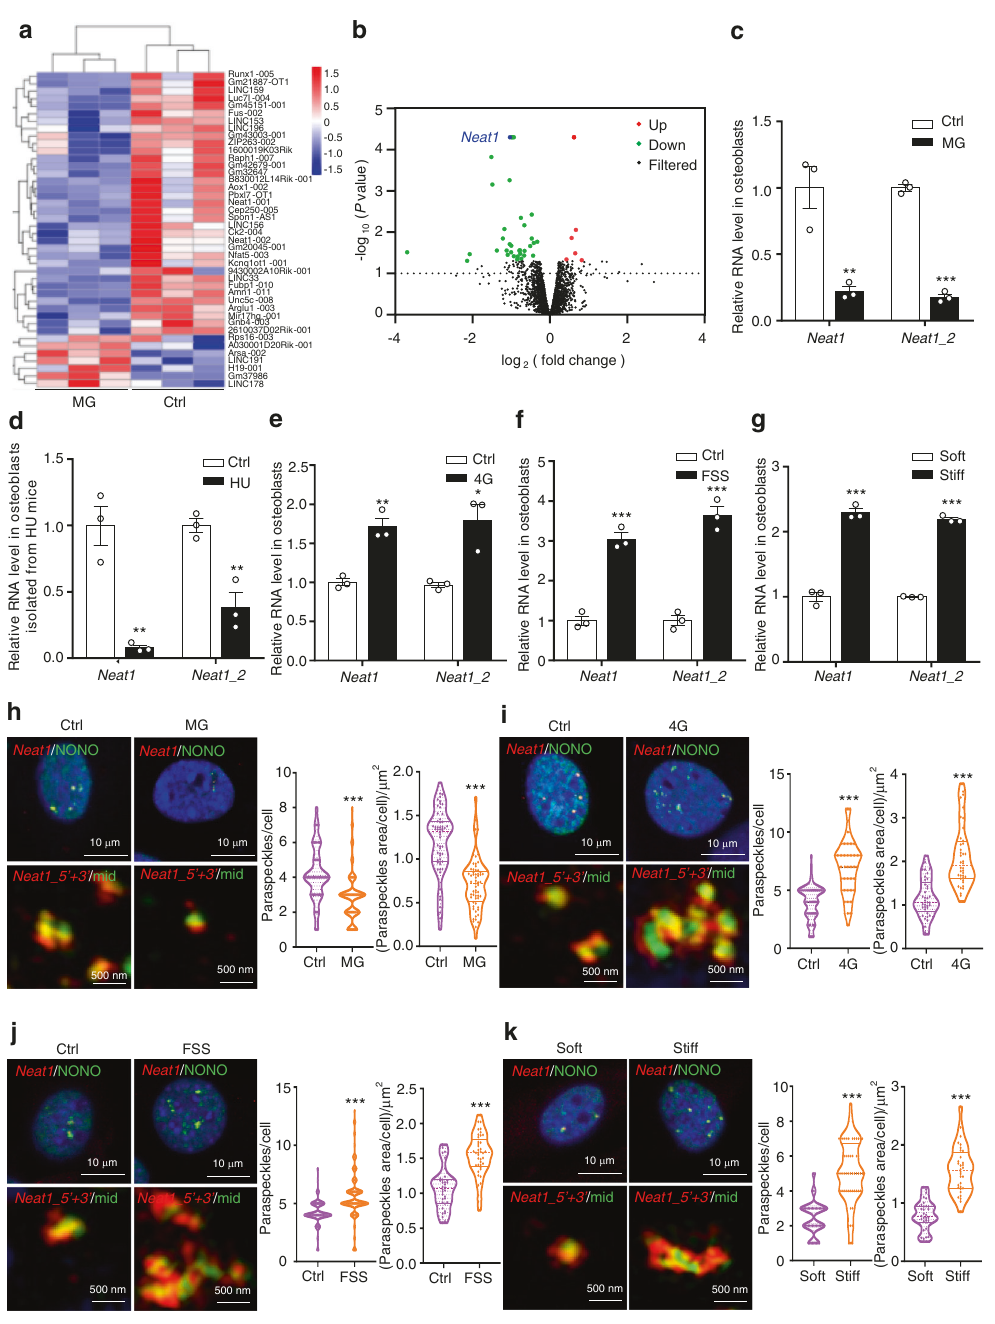
Fig. 1 Mechanosensitive lncRNA screening and paraspeckle changes in osteoblasts under different mechanical stimulations. a Heatmap of differentially expressed pro fi les of lncRNAs between the control and simulated microgravity (MG)-exposed mouse primary osteoblasts, as revealed by RNA-Seq with a cutoff fold change >1.3. n = 3 in each group. b Volcano plots indicating the altered lncRNAs in the control and MG-exposed mouse primary osteoblasts. c The expression of Neat1 and Neat1_2 in the control and MG-exposed osteoblasts. n = 3 in each group. d Analysis of total Neat1 and Neat1_2 expression in osteoblasts isolated from the control (Ctrl) mice and mice with hindlimb unloading (HU). e The expression of total Neat1 and Neat1_2 in the control and 4G mouse primary osteoblasts. f. Analysis of total Neat1 and Neat1_2 expression in the mouse primary osteoblasts treated with fl uid fl ow shear stress (FSS). The data from d – f are presented as the mean ± s.e.m. from three independent experiments. g The expression of total Neat1 and Neat1 -2 in mouse primary osteoblasts cultured on soft or stiff matrix. The results are presented as the mean ± s.e.m. from three independent experiments. h Representative images of paraspeckles in the control and MG-exposed mouse primary osteoblasts under confocal microscopy ( n = 83 and 96 cells in each group) and SIM microscopy ( n = 56 and 60 cells in each group). i Representative images of paraspeckles in the control and 4G mouse primary osteoblasts under confocal microscopy ( n = 71 and 83 cells in each group) and SIM microscopy ( n = 37 and 40 cells in each group). j Representative images showing paraspeckles in mouse primary osteoblasts under confocal microscopy ( n = 107 and 127 cells in each group) and SIM microscopy ( n = 34 and 41 cells in each group) after FSS treatment. k Representative images showing paraspeckles in the mouse primary osteoblasts cultured on soft and stiff matrix under confocal microscopy ( n = 52 and 60 cells in each group) and SIM microscopy ( n = 31 and 32 cells in each group). Paraspeckle quanti fi cation was performed and graphed to the right of each representative image. The experiments of h – k were